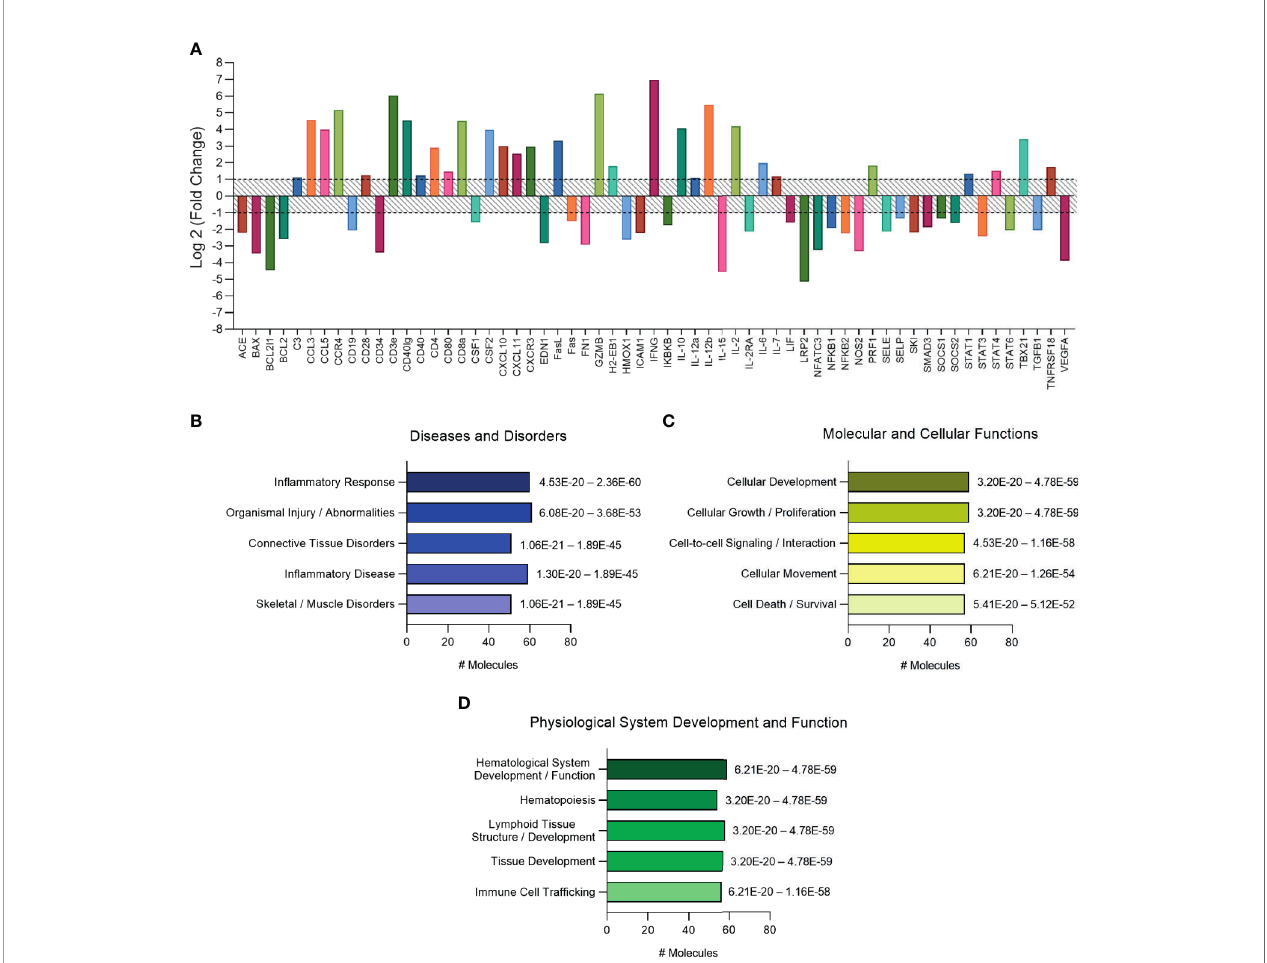
FIGURE 3 | Characterization of immune response expression pro fi le for the chronically infected group. (A) Overall expression of the altered immune response genes found in this study. Results were expressed as Log2 (Fold Change) and genes with fold change values under -1 (fold change 0.5) and over 1 (fold change 2) were considered altered and used for further analysis on IPA software. (B) Diseases and disorders pathway analysis. (C) Molecular and Cellular Function pathway analysis. (D) Physiological System Development and Function pathway analysis. Signi fi cance interval of enrichment is shown on the right of the bars. #: